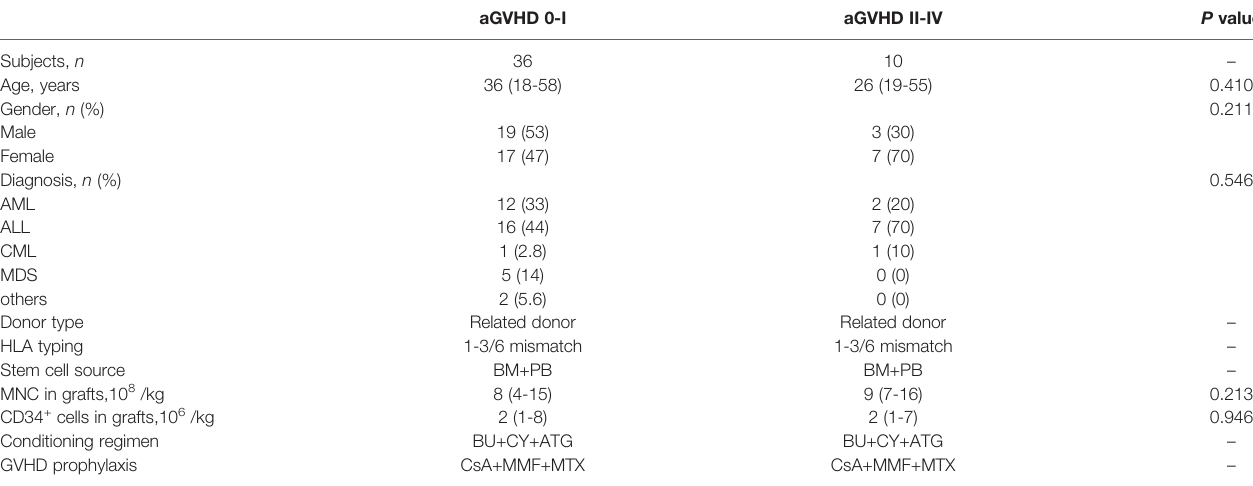
TABLE 1 | Clinical characteristics.